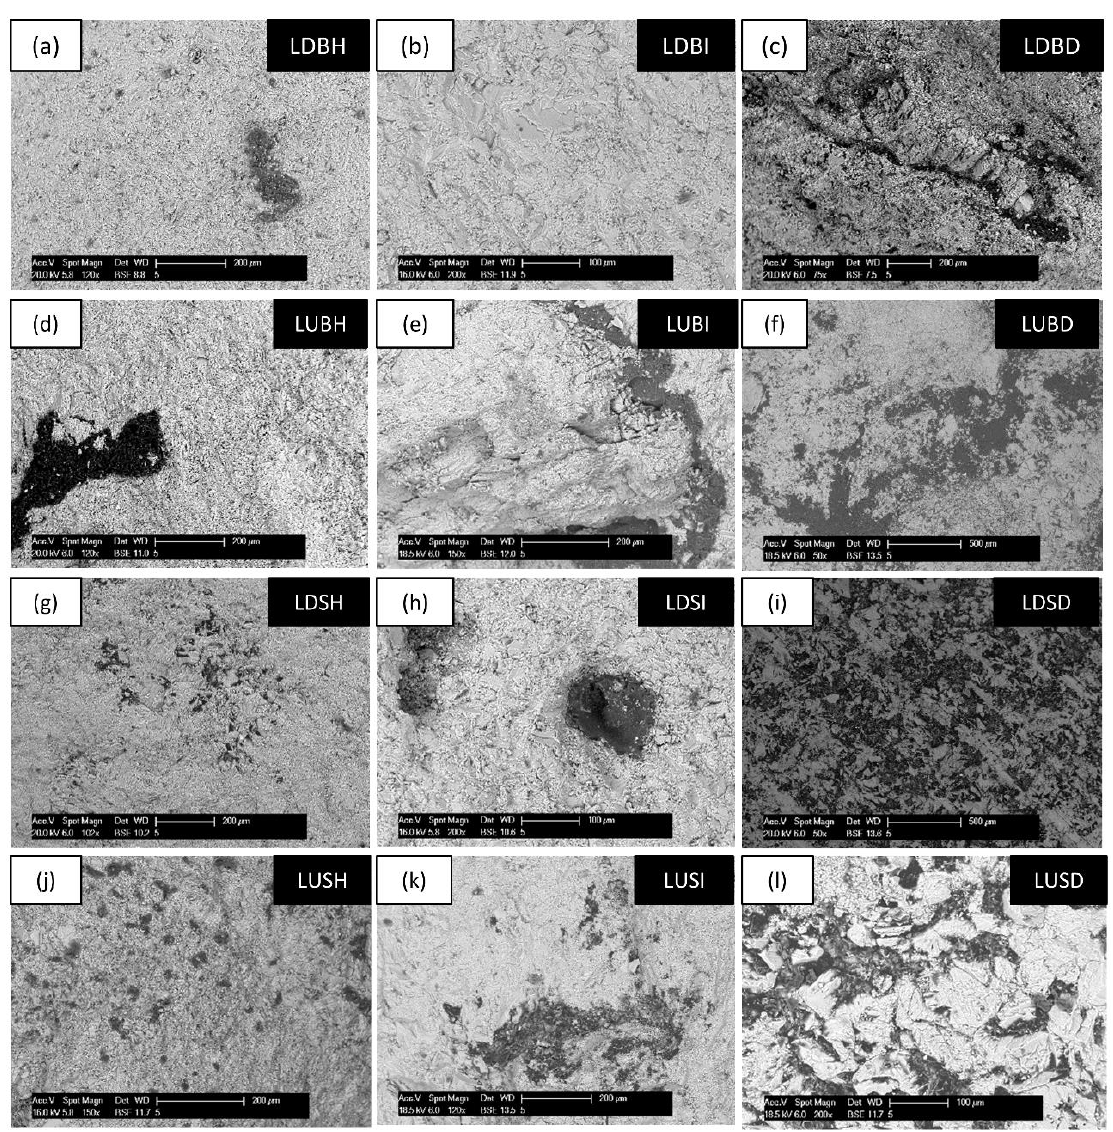
Figure 5. SEM micrographs of the limestone surfaces cleaned of blue and silver graffiti paints with Hydrogommage, IBIX, and dry-ice blasting. See Table 1 for samples’ nomenclature.